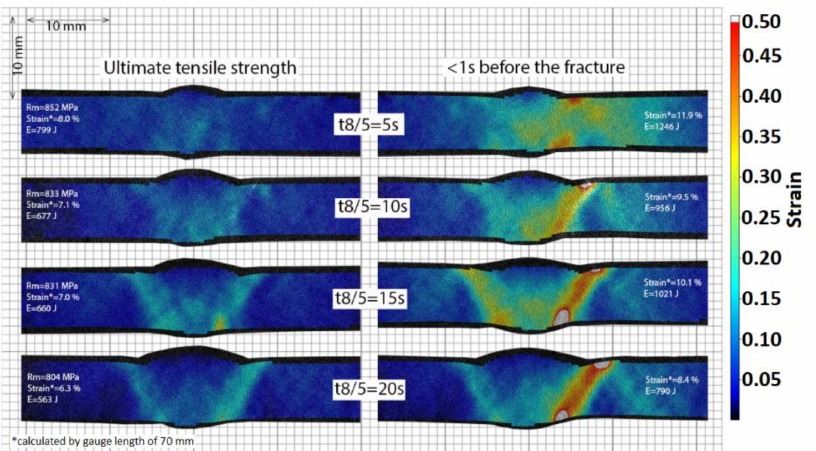
Figure 8. Results of DIC-measurements in specimens extracted from the steady-state domain from the welds of